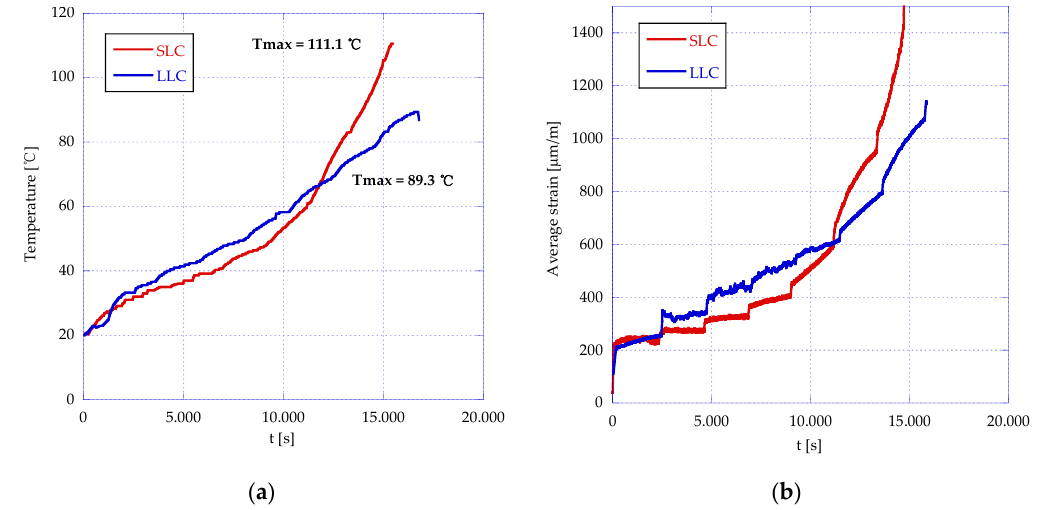
Figure 10. Evolution of maximum temperature ( a ) and average strain ( b ).